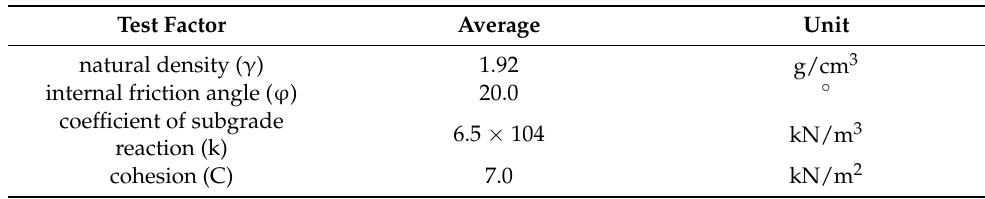
Table 2. Foundation soil parameters.